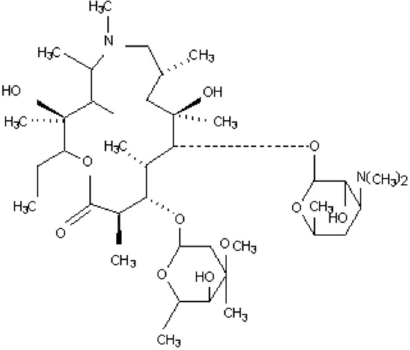
FIGURE 1 - Chemical structure of the azithromycin (C H N O . H O; M 785.02; CAS 36 72 2 12 2 r